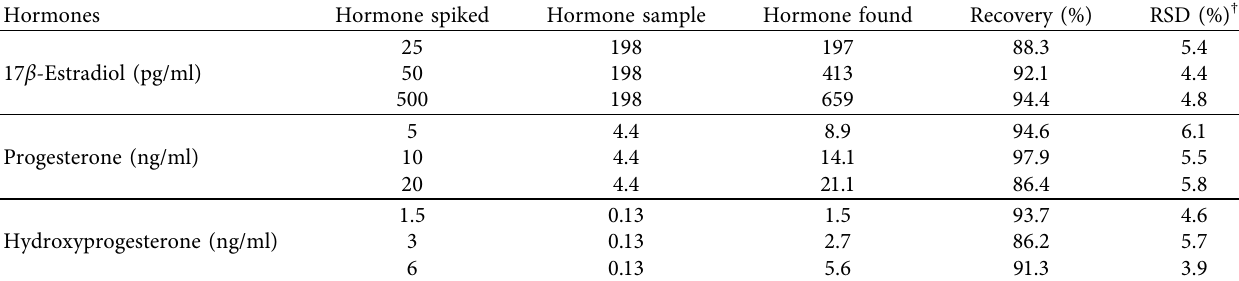
Table 2: Recoveries of steroid hormones in spiked milk samples.